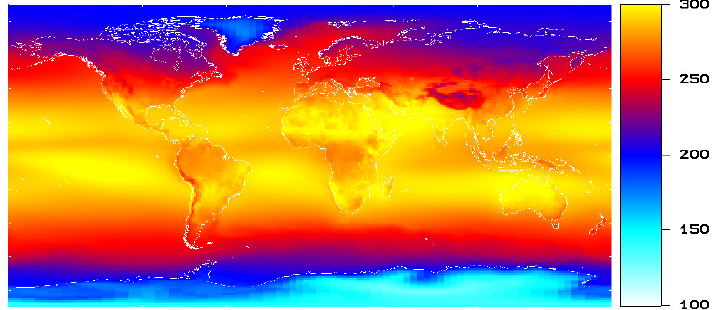
Figure 2. 2001–2017 mean clear-sky CERES OLR. The scale is in W/m 2